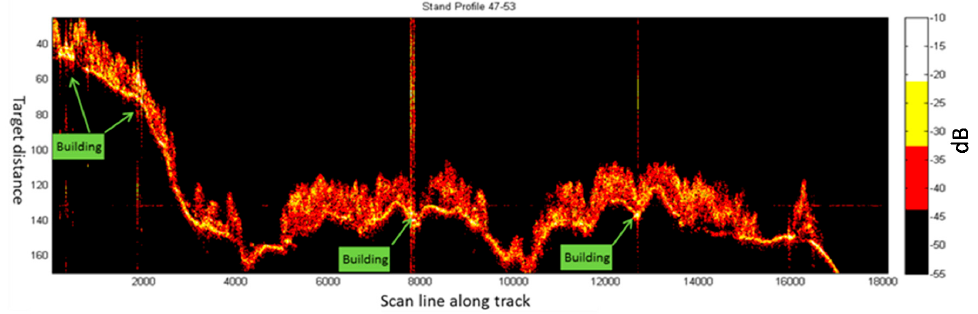
Figure 7. Stand profiles along one track during the field test.